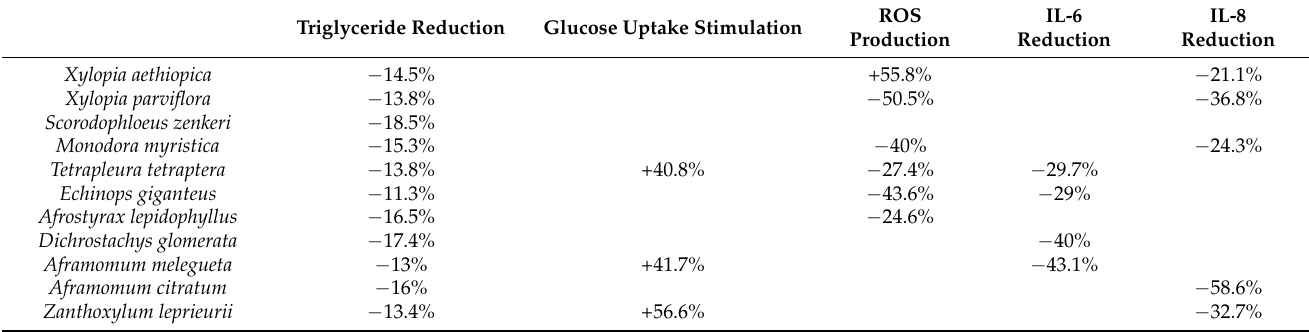
Table 3. Summary of the specific effects of the tested Cameroonian spice extracts on differentiated SW 872 adipocytes. Triglyceride Reduction Glucose Uptake Stimulation